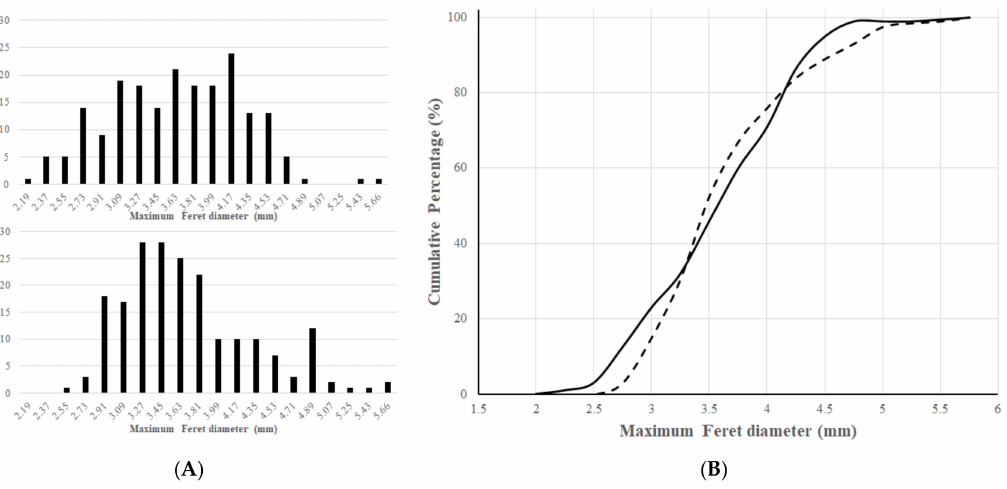
Figure 3. Particle size distribution of the matrix (( A ) and continuous line) and layered (( B ) and dashed line)